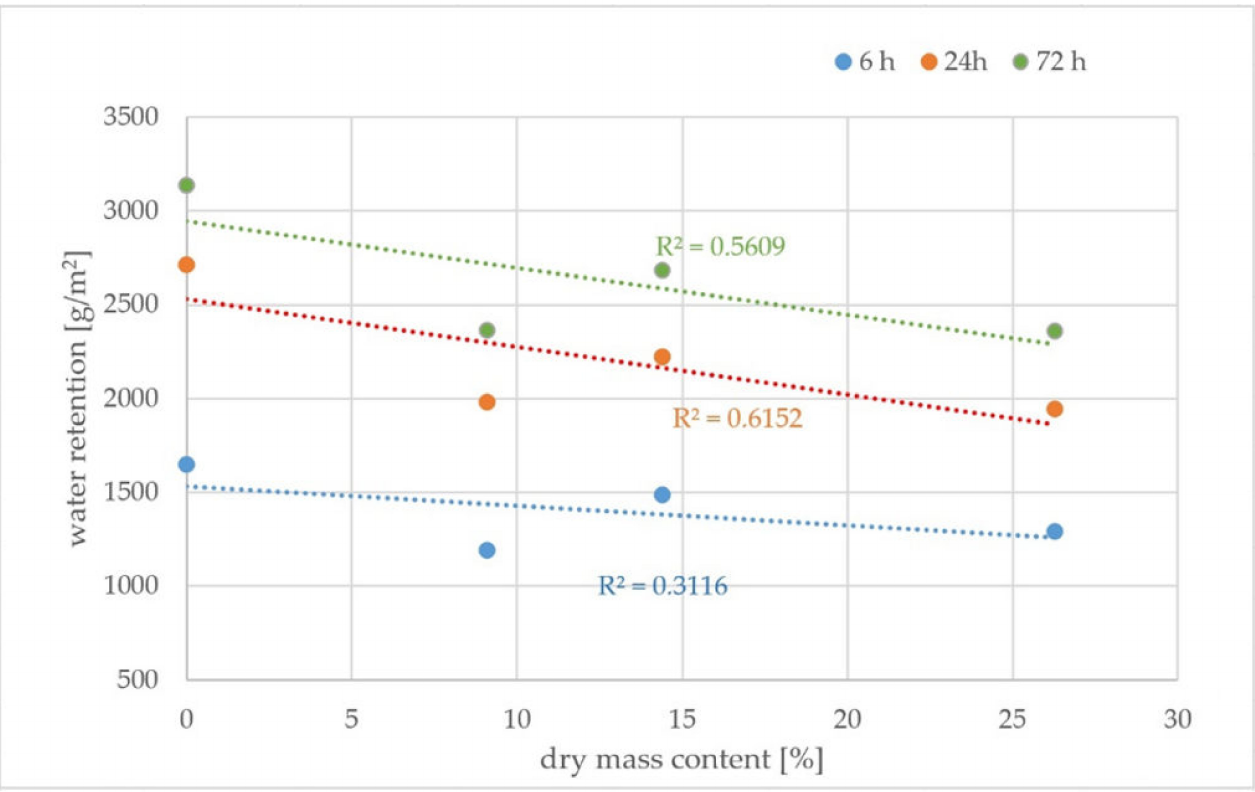
Figure 8. Correlation between water retention and dry mass for modified synthetic resins curing compounds.